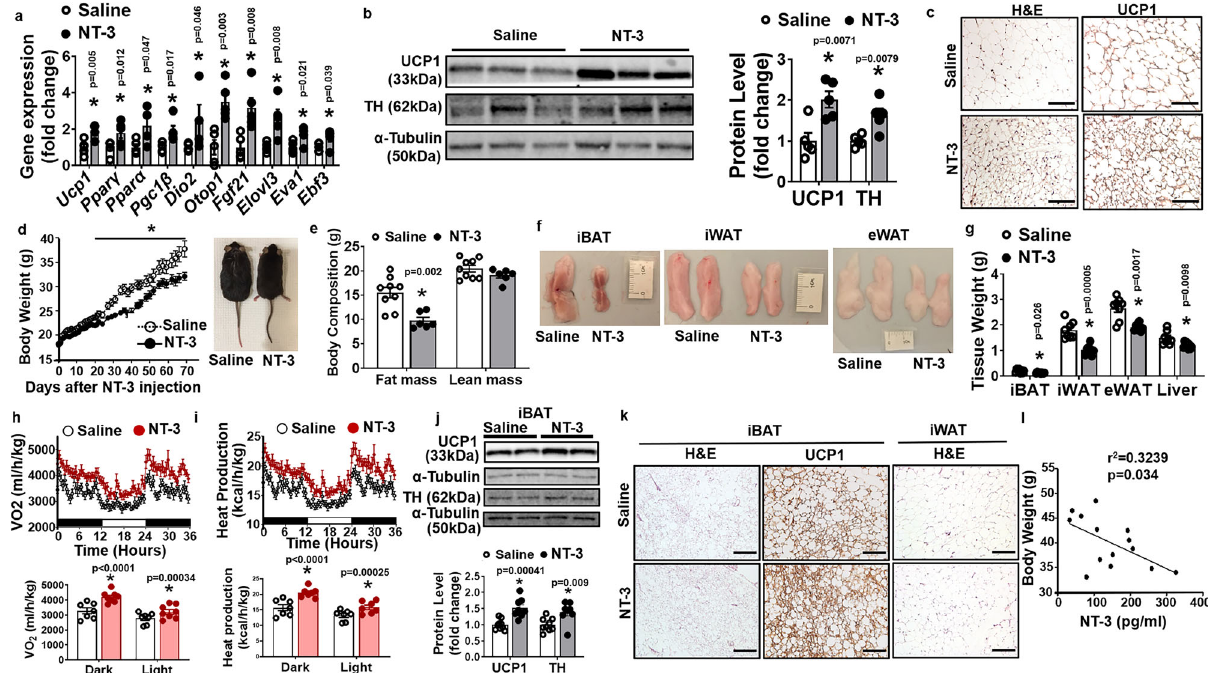
Fig. 2 Administration of NT-3 protein promotes beiging in postnatal mice and protects adult mice from diet-induced obesity. a – c Ucp1 and other BAT- speci fi c gene expression ( a , n = 5/group, * indicates statistical signi fi cance between saline and NT-3 treatments with unpaired two-tailed t test), UCP1 and TH protein levels ( b , n = 5/group, * indicates statistical signi fi cance between saline and NT-3 treatments with unpaired two-tailed t-test) and representative UCP1-immunostaining images showing UCP1-positive beige adipocytes in iWAT ( c , from three replicate animals/group, scale bar = 150 µ m) of 20-day-old postnatal pups with daily intraperitoneal (i.p.) NT-3 (50 μ g/kg) injection for 10 days. d – g Body weight ( d , saline n = 9; NT-3 n = 8. * Indicates statistical signi fi cance with unpaired two-tailed t test, saline vs NT-3 treatments: D19, P = 0.04; D20, P = 0.038; D21, P = 0.022; D22, P =